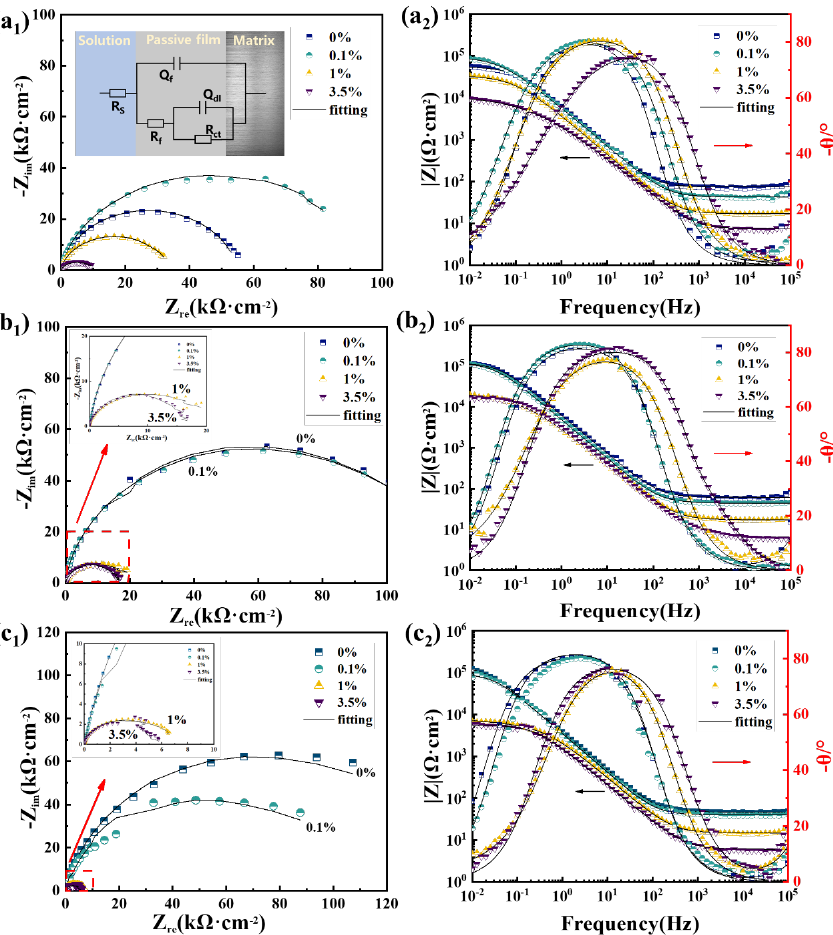
Materials 2022 , 15 , x FOR PEER REVIEW 12 of 18 Figure 8. EIS plots of the passive film for ( a ) BM, ( b ) Cr, and ( c ) RE steel rebars in simulated solutions (1-Nyquist plots and 2-Bode plots). The equivalent electrical circuit for EIS data is inserted in ( a 1 ).